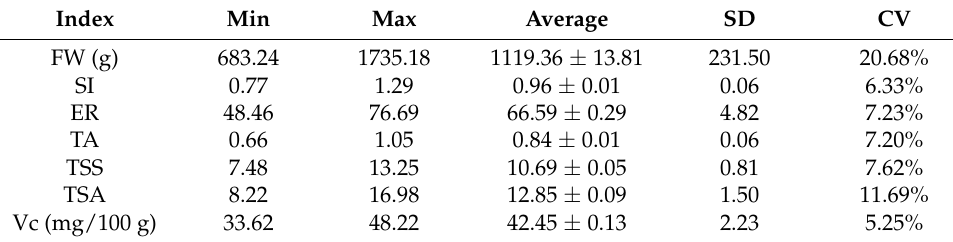
Table 1. Fruit quality of Guanxi pomelo orchards in Pinghe, Fujian,